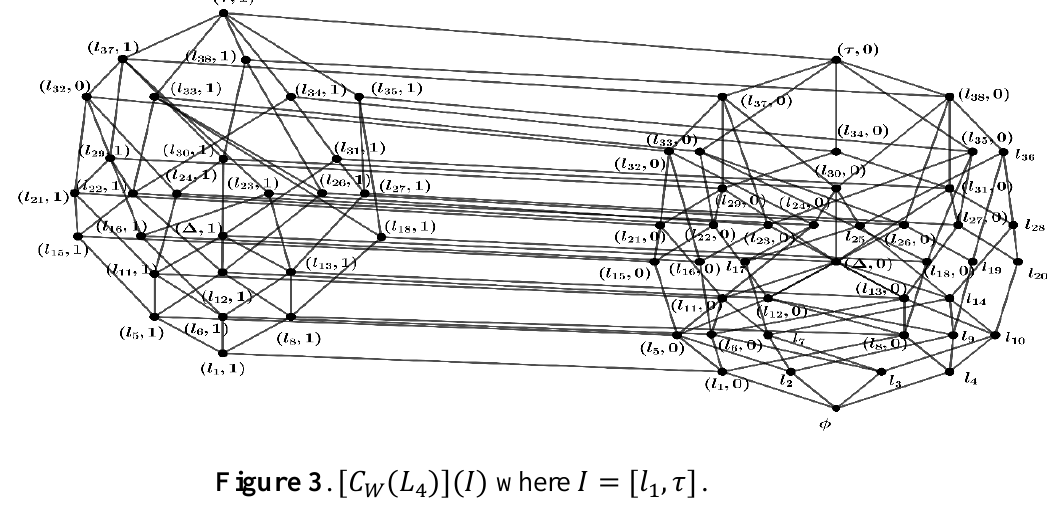
(𝐿 )](𝐼) where 𝐼 = [𝑙 𝑊 4